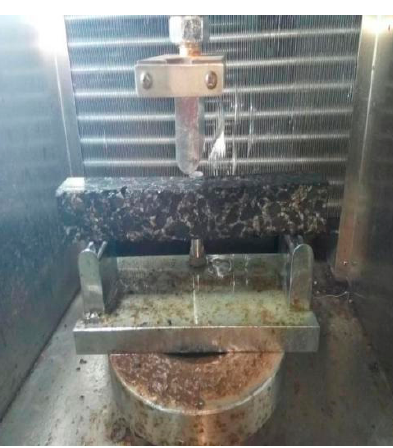
Table 7. Test results of physical properties of each fiber asphalt mastic. Technical Index